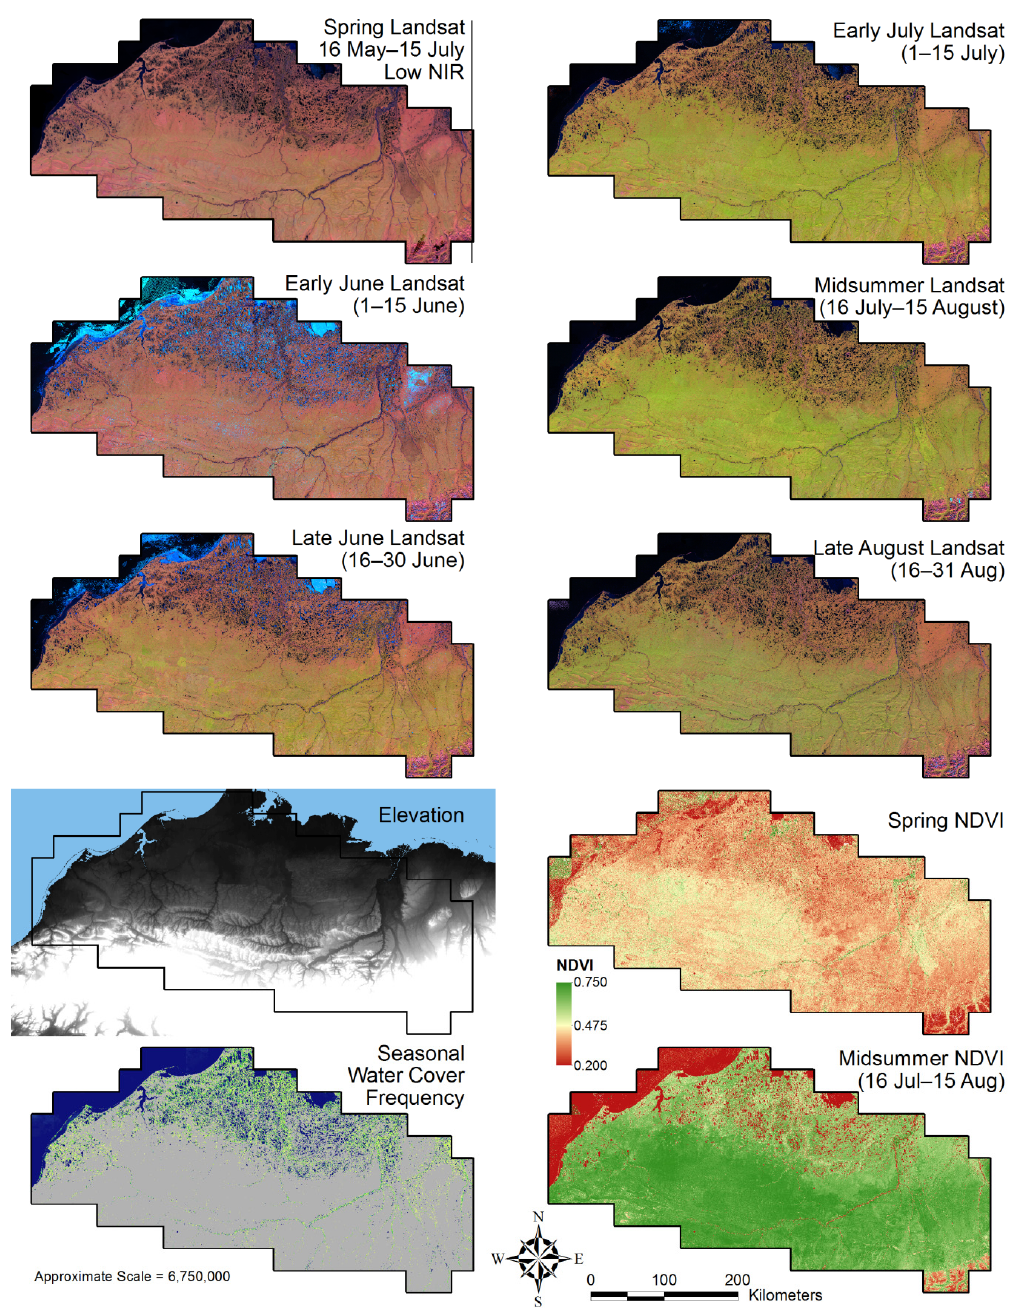
Figure 4. Selected spectral and ancillary predictors used to predict cover of PFTs and other cover types, North Slope, Alaska.